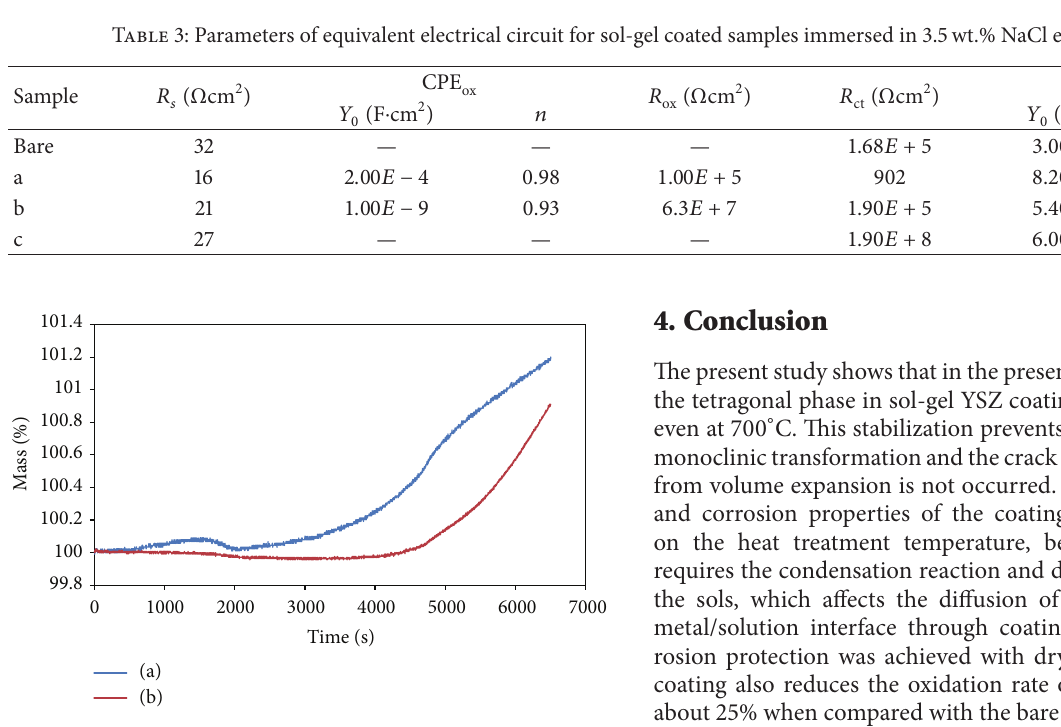
Figure 7: Weight gain versus time curves for (a) bare and (b) coated zircaloy-4 exposed to air at 800 ∘